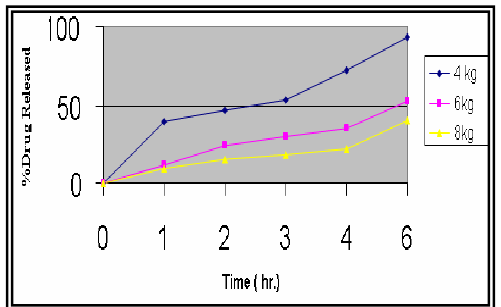
Figure 4 : Effect of compression force on percent released of nicotine at pH 6.8 and 37 0 C.